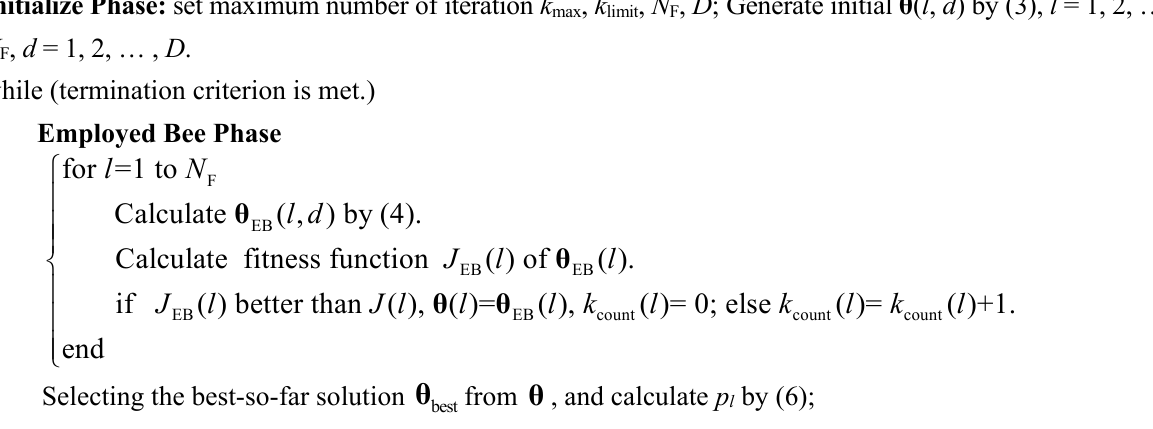
Figure 3. Optimization mechanism of different ABC algorithms: ( a ) original ABC algorithm; ( b ) improved ABC algorithm. Table 1. Pseudocode of the improved ABC